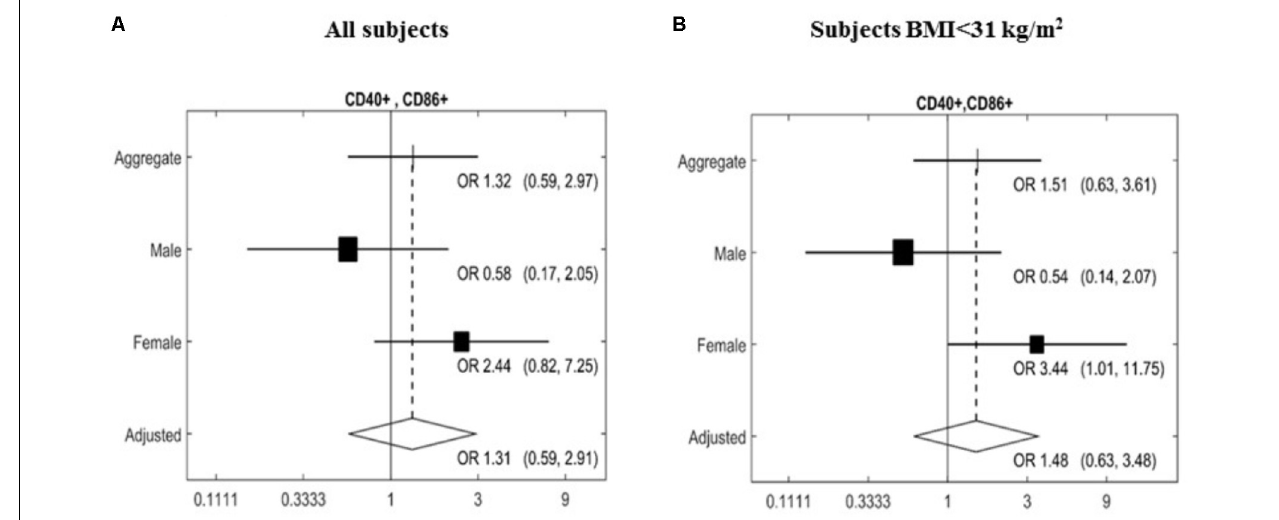
FIGURE 2 | Effects of MedDiet on CD40 + CD86 + expression following in vitro challenge with TLR agonists. PBMC were cultured with a cocktail of TLRs agonists (PolyA:U, Imiquimod, ODN-M362, LPS, Pam2CSK4) for 22 h. Forest plot of the study of the CD40 + CD86 + lymphocytes comparing the association between Mediterranean diet and normal diet after 1 year of intervention with the random effect model. Associations were investigated based on an adjusted Mantel–Haenszel odds ratio (OR), stratified by gender (A) or BMI > 31 kg/m 2 (B) . OR and 95%Cl were calculated. Cl, confidence interval.